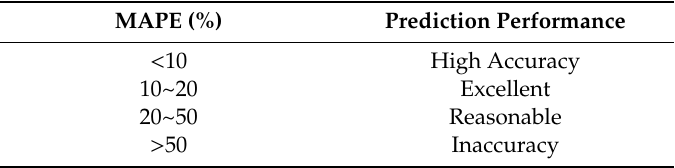
Table 1. Mean absolute percentage error (MAPE) evaluation